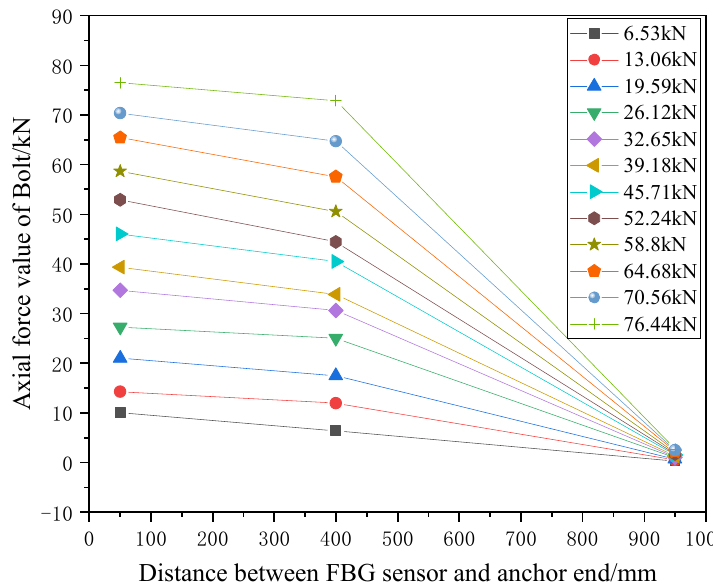
Figure 11. Axial force distribution of bolt under different pull-out loads.